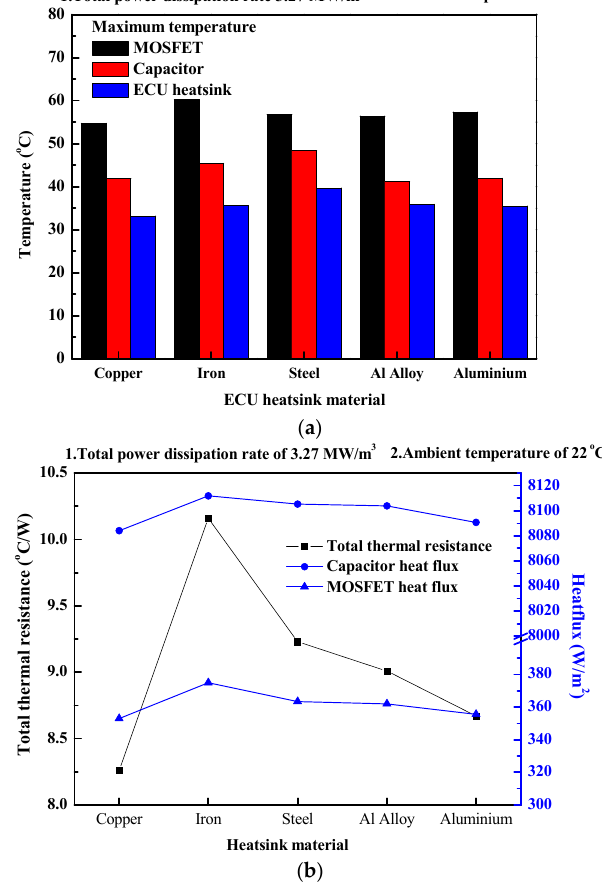
Figure 9. Temperature, total thermal resistance and heat flux of the 36V heatsink ECU system with different ECU heatsinks: ( a ) Maximum temperature variations; ( b ) Total thermal resistance and heat flux variations with the heatsink material.